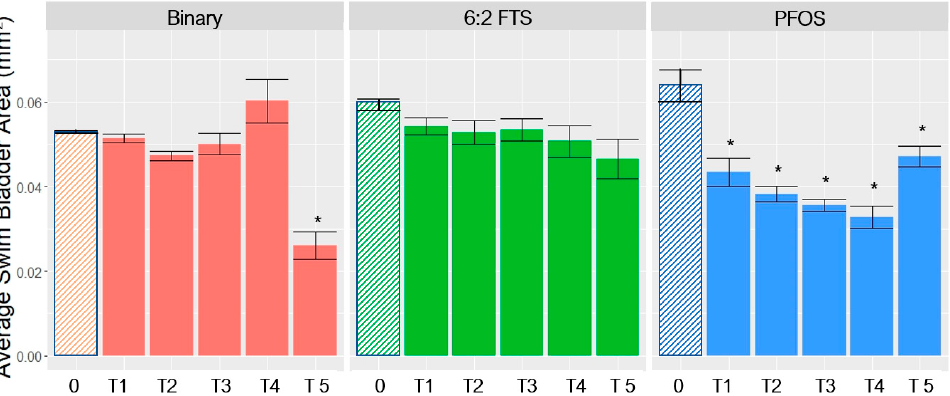
Figure 2. ANOVA and multiple comparison results for mean swim bladder area (SBA). * = statisti- cally significant ( p < 0.05). Mean ± SEM of three replicates for each treatment group. 0 = control group; T1 to T5 are treatment groups (see Tables 1 and S1 for measured concentrations).